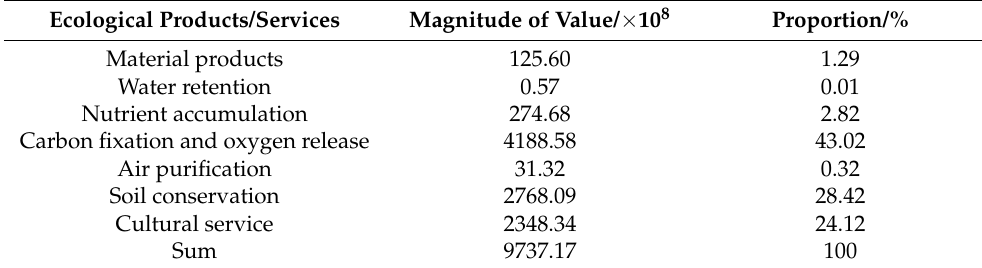
Table 2. The value of forest ecological products in Zhejiang Province in